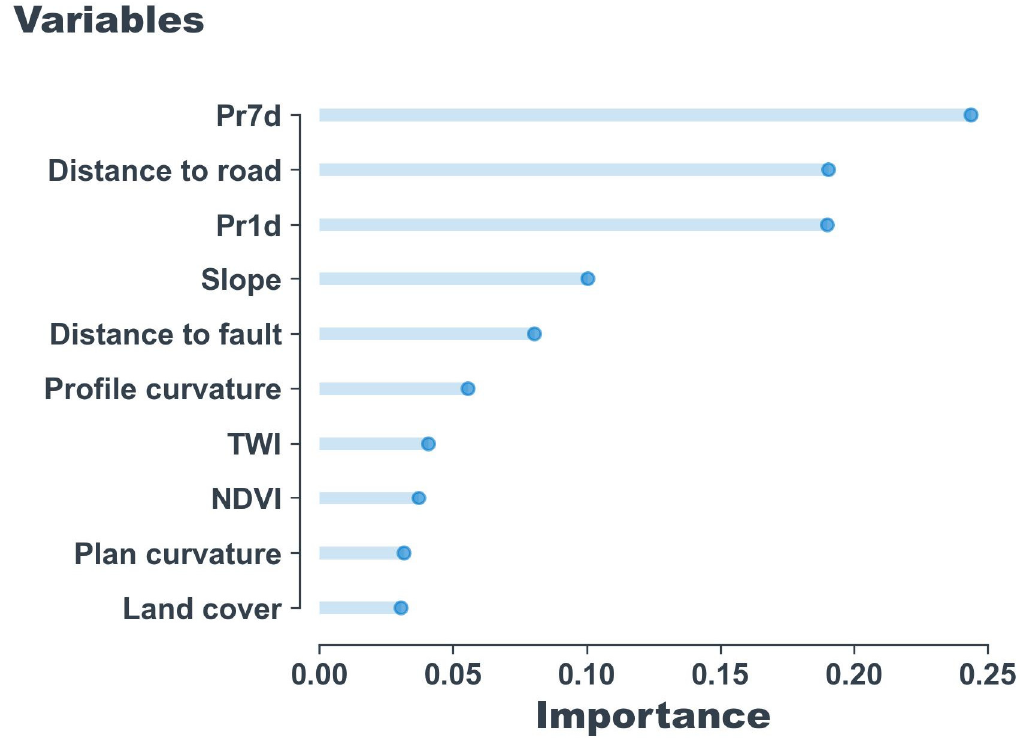
Figure 8. Relative importance of the conditioning factors in the global dynamic rain-fall induced LMS model for using RF.